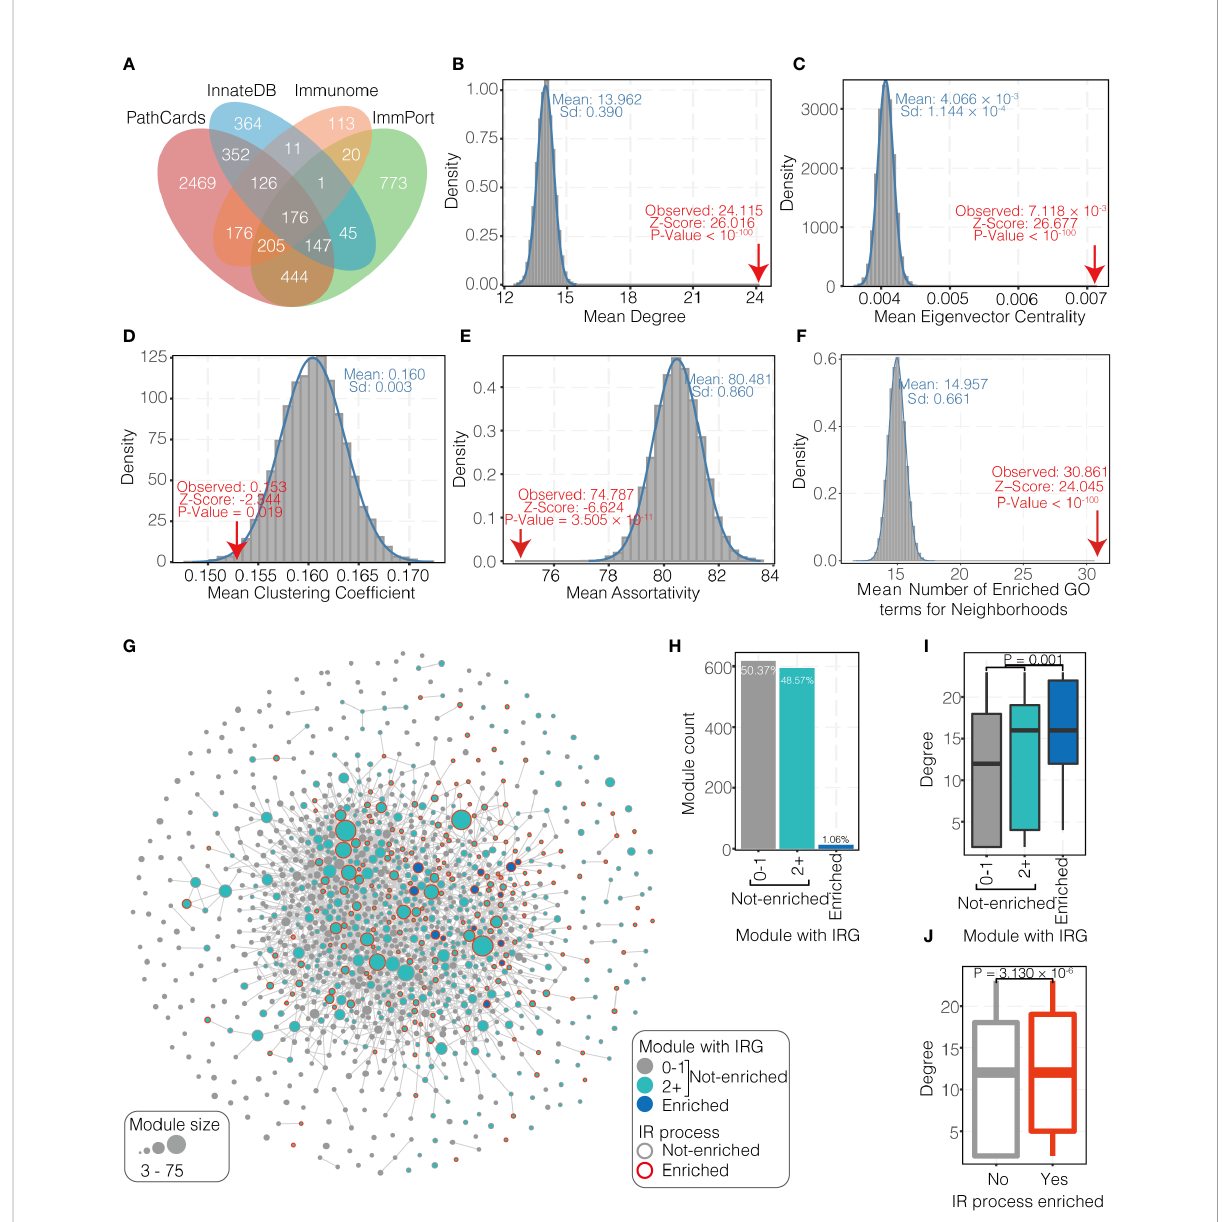
FIGURE 2 Immune-related genes (IRGs) in PPI network. (A) The statistics of IRGs from four databases. (B-E) Network properties (degree, eigenvector centrality, clustering coef fi cient, and assortativity, respectively) of IRGs. (F) Number of enriched GO terms for neighborhoods of IRGs. (G) Network of 1,225 modules identi fi ed through MCL clustering of HUMPPI-2022. Nodes represent distinct modules and the size re fl ect the gene number in each. Nodes are connected with signi fi cant link (see Methods). Green nodes mean modules containing two or more IRGs and not enriched with IRGs; Blue nodes mean modules that are enriched with IRGs (1% FDR); and modules containing less than two IRGs are colored in grey. Nodes with red border represent modules enriched to IR (immune-related) process. (H) Relative fractions of 1,225 modules that contain speci fi ed numbers of IRGs. (I) Comparison of network connectivity (degree) for modules that contain speci fi ed numbers of IRGs. (J) Comparison of network connectivity for modules that enriched to IR and non-IR